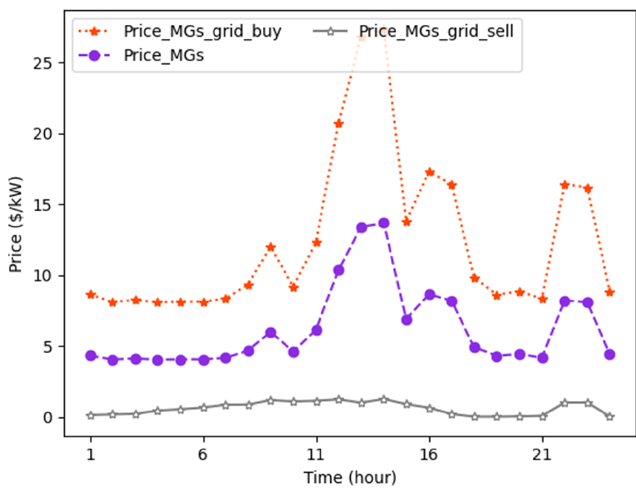
Figure 6. WT, PV output, and load power curve of MG 2.